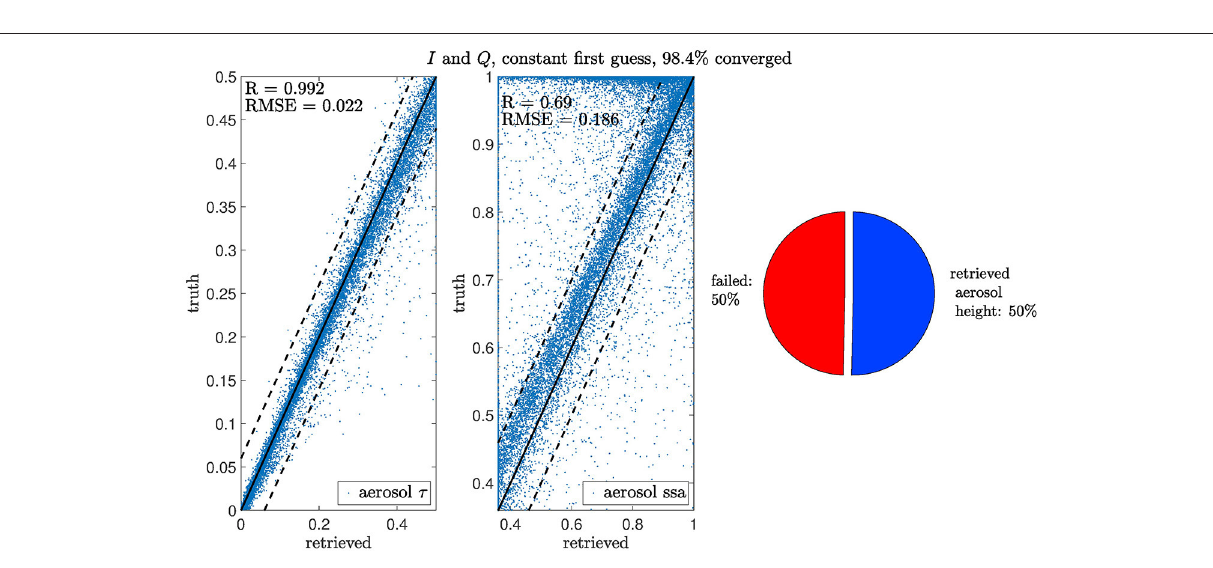
FIGURE 5 | Same as Figure 4 except with a “naive” first guess. A retrieval that makes use of both I and Q , despite using a “naive” first guess, nonetheless appears to work reasonably well for retrieving optical depth and single-scattering albedo, but not aerosol vertical